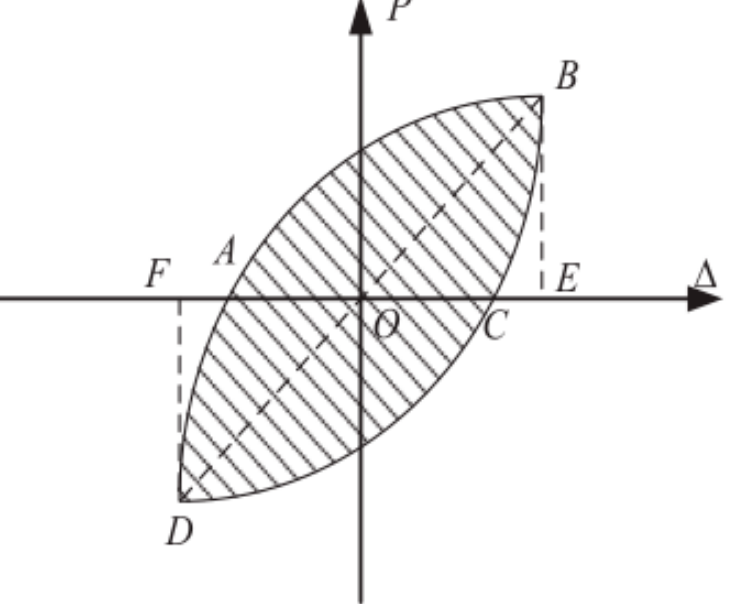
Figure 14. Calculation of the equivalent viscous damping ratio. small when longitudinal yielding was not yielding in the initial loading stage.